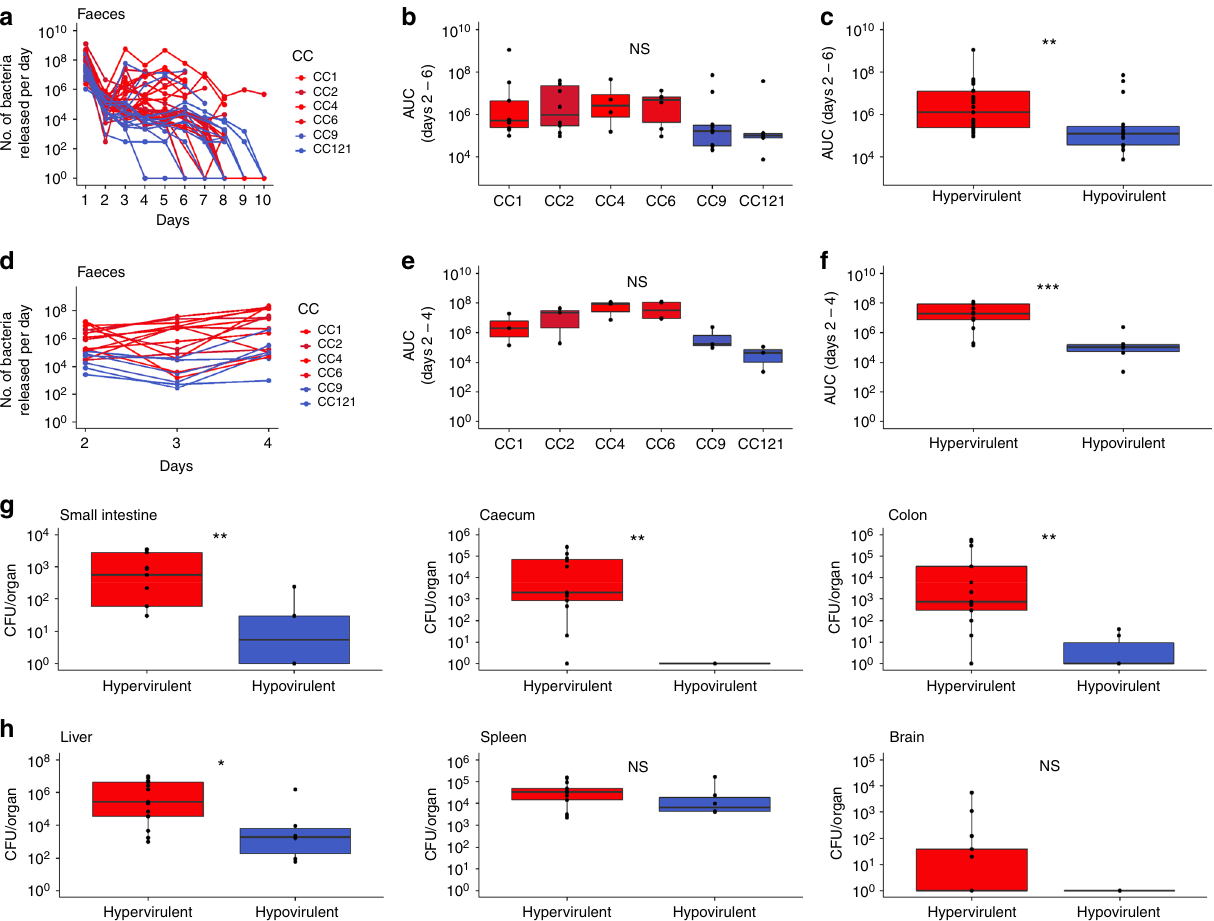
Fig. 6 Gut colonization capacities of Lm clones. Colonization capacity of clones was assessed by orally inoculating mEcad E16P KI female C57BL/6J mice 62 by mixes of seven isolates of the same CC (tested CCs: CC1, CC2, CC4, CC6, CC9, and CC121), and by enumerating the total bacteria released in mice stools every day (see Methods section). a – c Each mouse was orally infected by 2 × 10 7 bacteria. n = a minimum of 4 mice per CC. a Number of bacteria of each CC released in mice stools per day. b , c Area under the curves of panel a per CC is shown in b and for hypervirulent (CC1, CC2, CC4 and CC6) and hypovirulent (CC9 and CC121) CCs in c , calculated for the interval between days 2 and 6. d – h Each mouse was orally infected by 2 × 10 8 bacteria. n = a minimum of three mice per CC. d Number of bacteria of each CC released in mice stools per day. e , f Area under the curves of panel d per CC is shown in e and for hypervirulent (CC1, CC2, CC4, and CC6) and hypovirulent (CC9 and CC121) CCs in f , calculated for the interval between days 2 and 4. g CFU counts for intestinal organs (small intestine, cecum, and colon) treated with gentamicin (100 μ g/mL; 2 h) of mice killed on the 4th day after inoculation. h CFU counts for deeper organs (liver, spleen, mesenteric lymph nodes, and brain) of mice killed on the 4th day after inoculation. Colors are as in Fig. 1a. In boxplots, the boxes delimit the fi rst (25%) and third (75%) quartiles, whereas the bars delimit the second quartile (median). Outliers are outside the whiskers. Mann – Whitney U test was used for statistical comparisons. *** p < 1.10 − 3 ; ** p < 1.10 − 2 ; * p < 0.05. NS: Not signi fi cant. AUC: Area under the